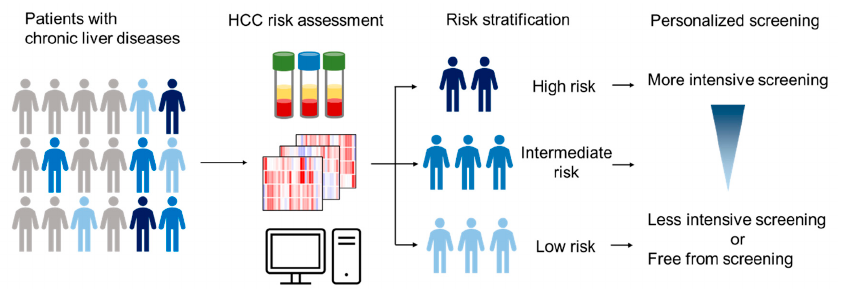
Figure 1. Stratified hepatocellular carcinoma (HCC) screening tailored by predicted individual HCC risk.